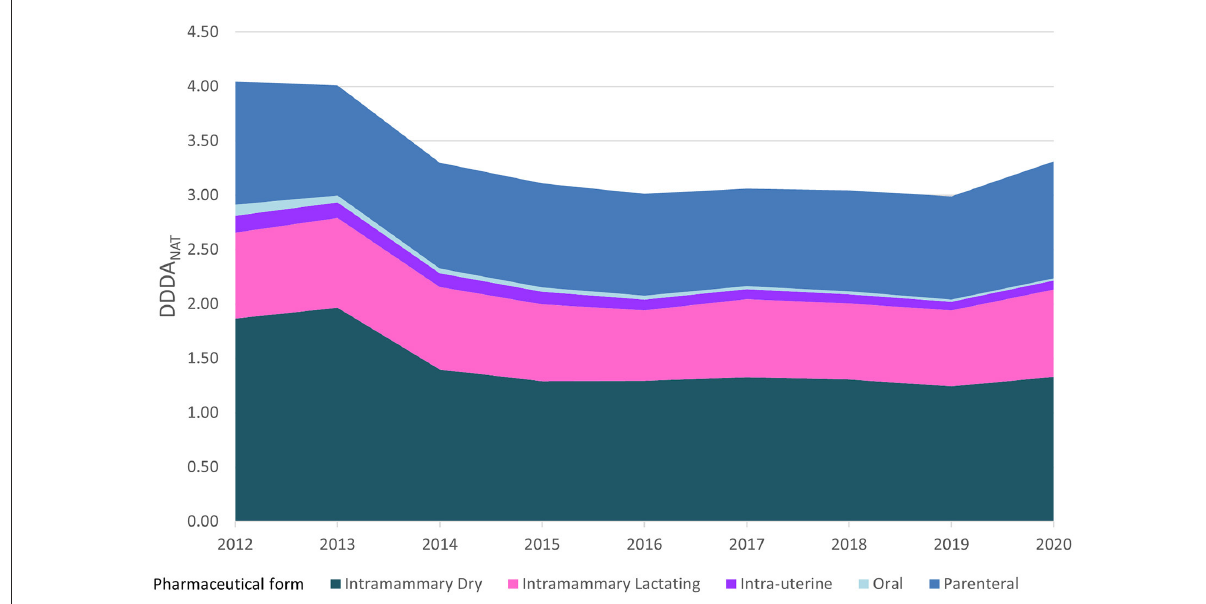
FIGURE3 Antimicrobial consumption in the Dutch dairy sector, in DDDA NAT units, on a yearly basis from 2012 to 2020, segmented into the different pharmaceutical formulations and the respective weight proportion in each year.